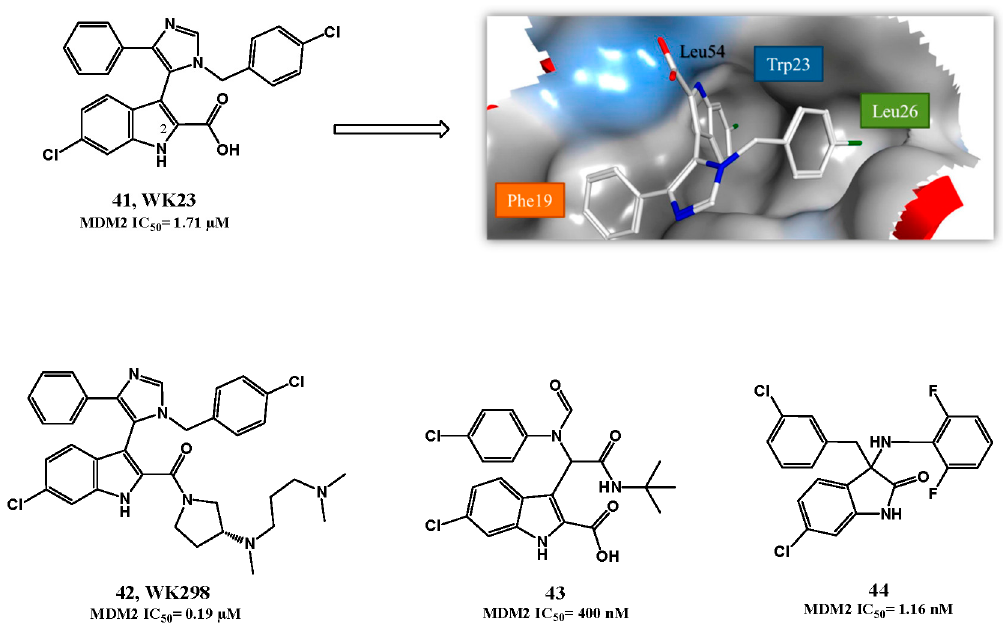
Figure 11. Indolyl derivatives. Right upper quadrant: structure of compound 41 bound to MDM2 (PDB 1YCR). MDM2 surface is colored in blue for hydrophilic areas and grey for hydrophobic areas. Compound 56 is depicted in stick model and is colored according to element type: white for carbon atoms, blue for nitrogen atoms, red for oxygen atoms, and green for chlorine atoms.